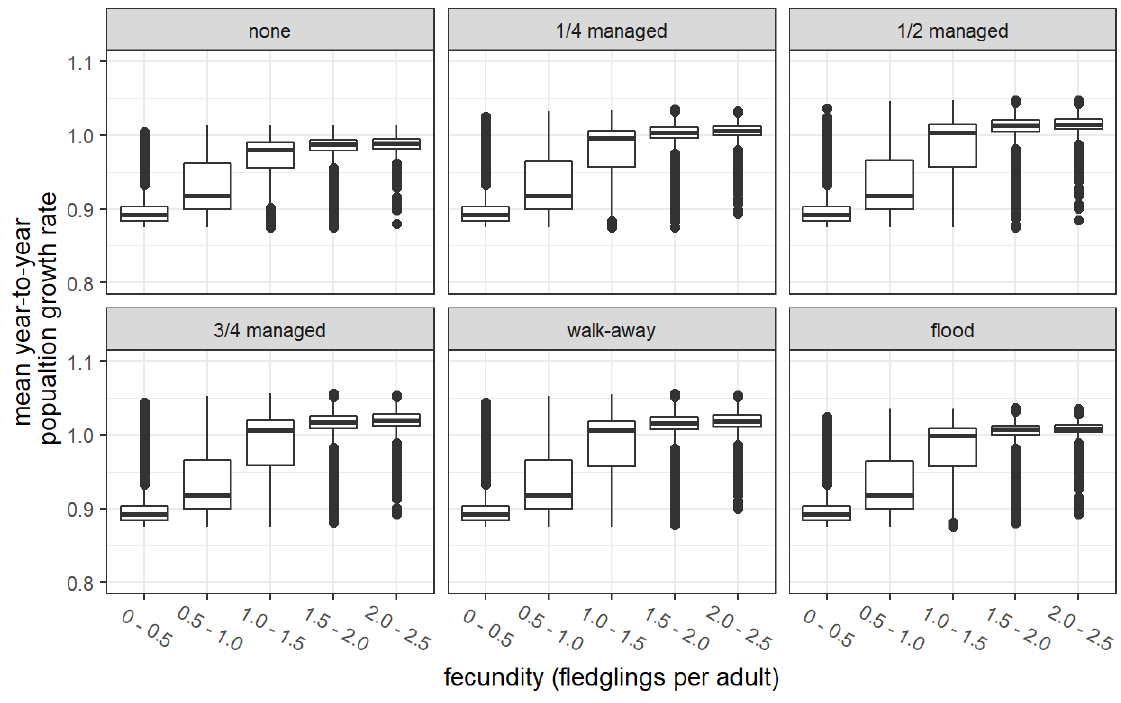
Figure A2.3. Geometric mean of year-to-year population change over the duration of the simulation. Results are summarized under the full range of parameter uncertainty for six potential habitat management scenarios. Results are grouped by fecundity ranges achieved after simulated impact from Brown-headed Cowbird brood